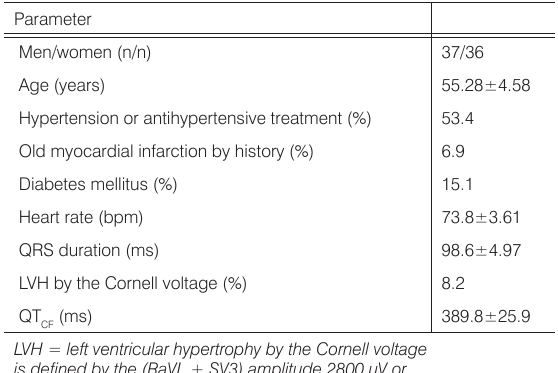
Table 1. Baseline characteristics of the studied